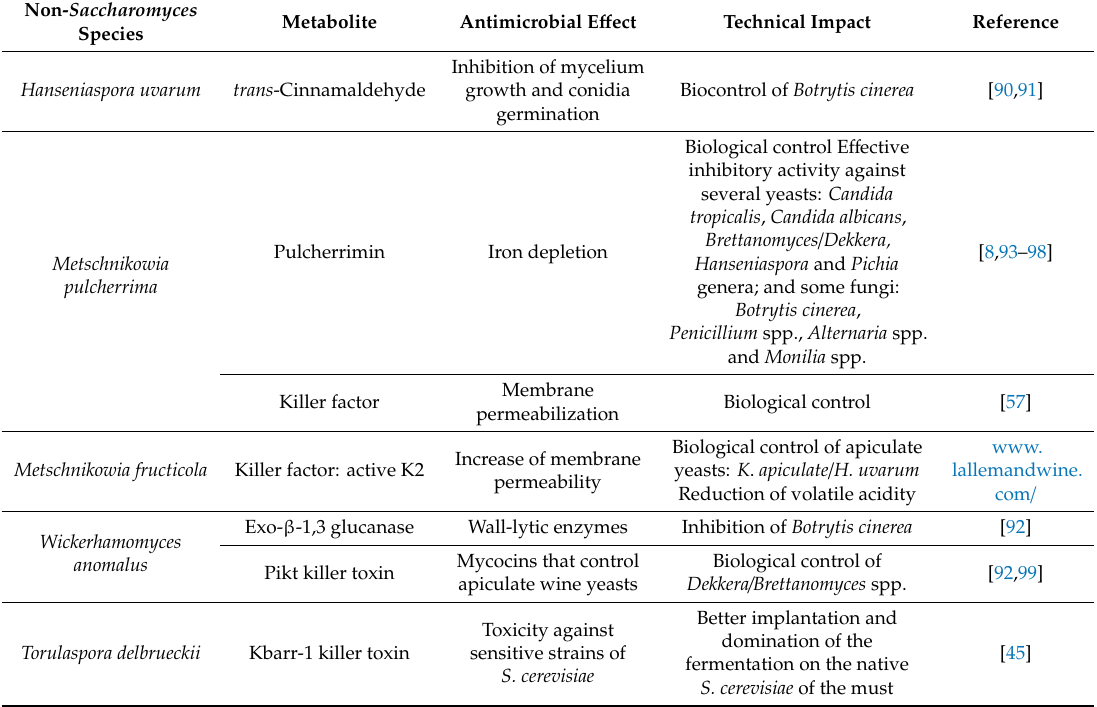
Table 4. Non- Saccharomyces yeast species involved in the production of biocontrol agents. Non- Saccharomyces